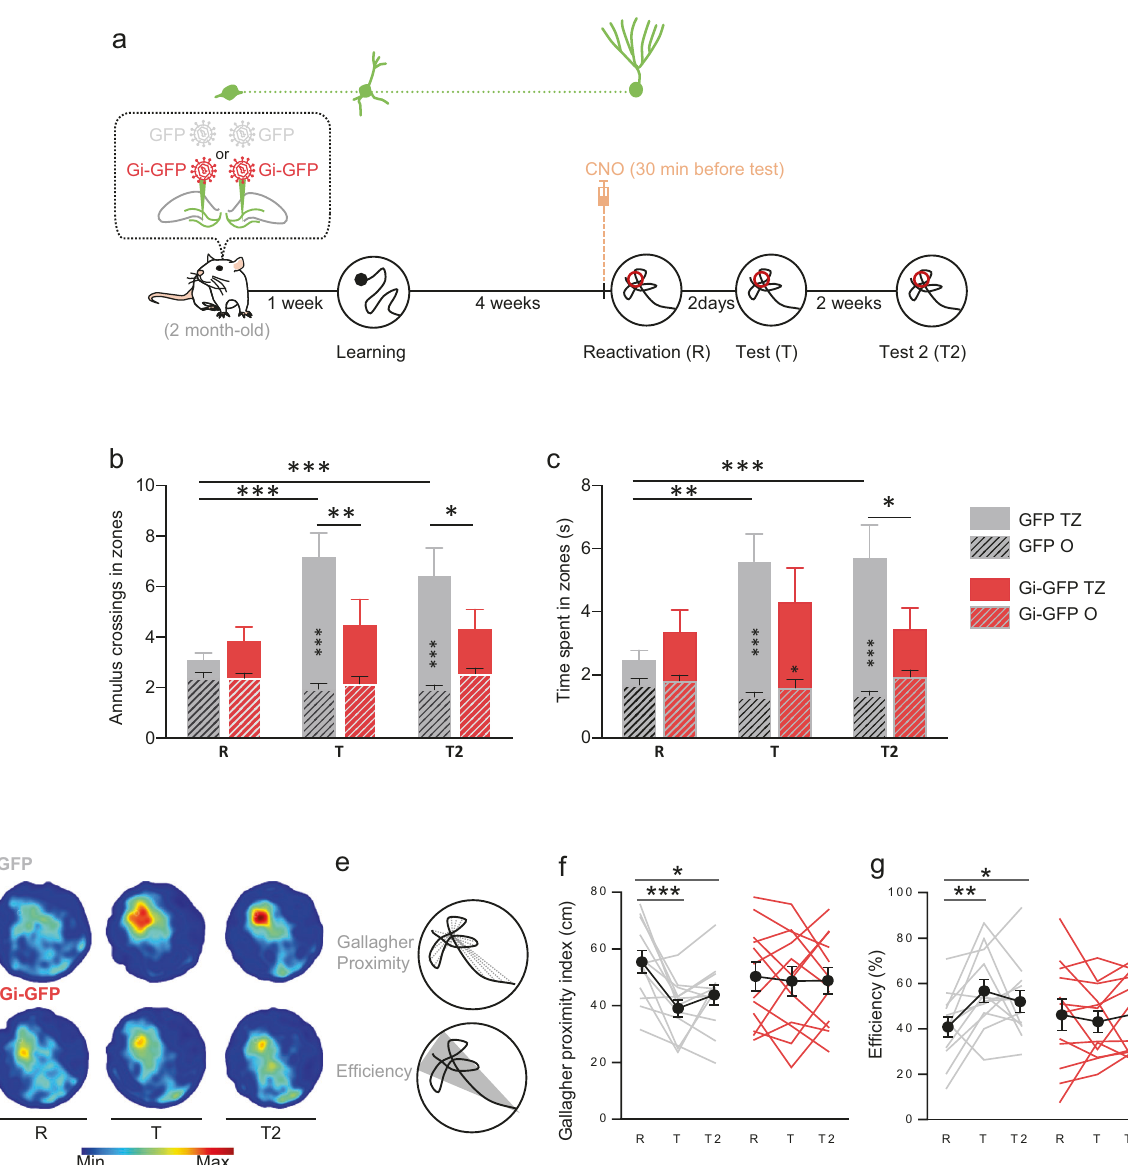
Fig. 6 Silencing during reconsolidation, neurons that were immature at the time of learning, impairs memory update. a Experimental protocol: 2- month-old rats were injected with Gi-GFP RV ( n = 12) or its control GFP RV ( n = 12) 1 week before MWM training. Rats were trained for 6 days and memory was reactivated 4 weeks later. Thirty minutes before reactivation, rats were injected (i.p.) with 1 mg/kg CNO. Memory was tested 2 days later (Test) and again 2 weeks later (Test 2). At the end of each reactivation and test sessions, the Atlantis platform (indicated by ○ ) raised and rats were put on the platform for 30 s. b , c Cross entries and time spent in the MWM zones (T: Target zone; O: others zones). The reactivation with the Atlantis platform led to an increase in the number of entries and the time spent in the target zone at the test for the GFP control rats at test T and T2 (Tukey ’ s test: * p < 0.05, ** p < 0.01, *** p < 0.001). Atlantis reactivation had no effect on Gi-GFP performances at the tests. GFP rats enter more and spent more time in the target zone during tests than Gi-GFP rats (Tukey ’ s test: * p < 0.05, ** p < 0.01). d Density plot for grouped data: The color level represents the lowest (Min) to the highest (Max) location frequency in pixels. e Gallagher Proximity: Average distance of rats from the former platform during the fi rst 20 s. Ef fi ciency: Percentage of distance crossed in the represented triangular zone. f , g Gallagher Proximity and Ef fi ciency during reactivation and tests. Atlantis reactivation led to an increase in Gallagher and Ef fi ciency performances at the tests for the GFP control rats (Tukey ’ s test: * p < 0.05, ** p < 0.01, *** p < 0.001). Atlantis reactivation had no effect on Gi-GFP performances at the tests. All data shown are mean ± s. e.m. For statistical details, see Table